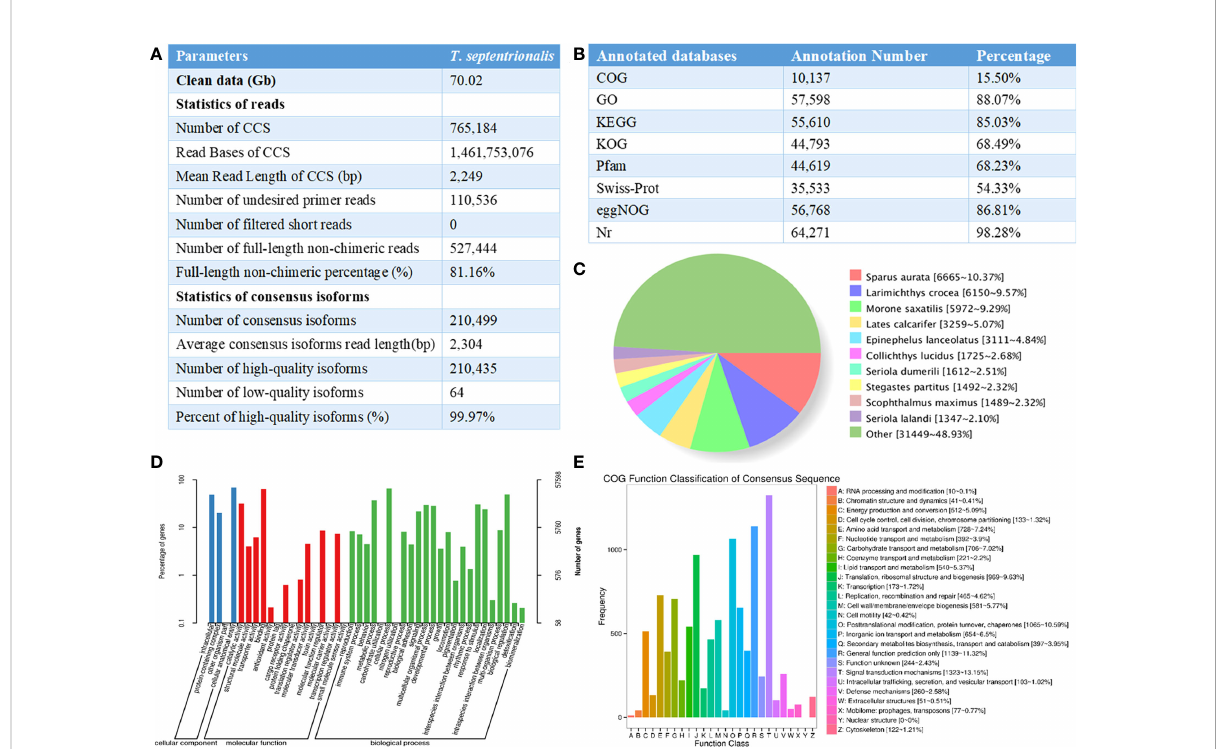
FIGURE 1 (A) Summary for the full-length transcriptome of Thamnaconus modestus ; (B) Statistics of the annotation results; (C) The distribution diagram of species with homologous sequences in NR. (D) Go functional annotation of the Thamnaconus modestus transcriptome. The x-axis represents different gene categories, the right and left y-axis indicate the number of transcripts and percentage of genes. (E) Functional annotation of the T. transcriptome full-length transcripts using COG database, letters on the x-axis represents different COG categories shown detail on the right legend, the y-axis represents the number of the